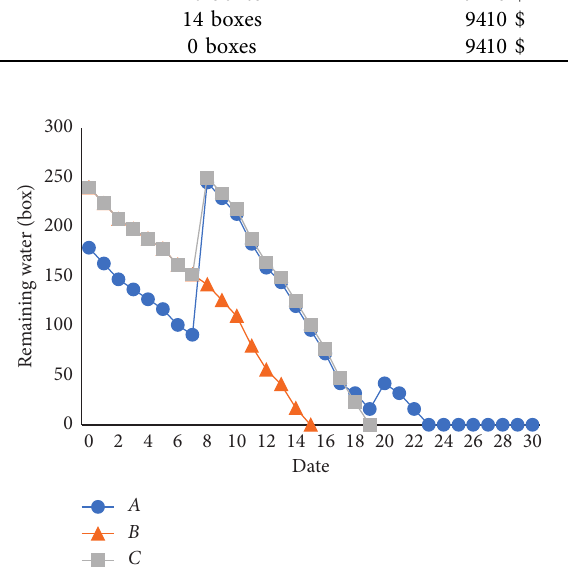
Figure 14: Comparison of remaining water.